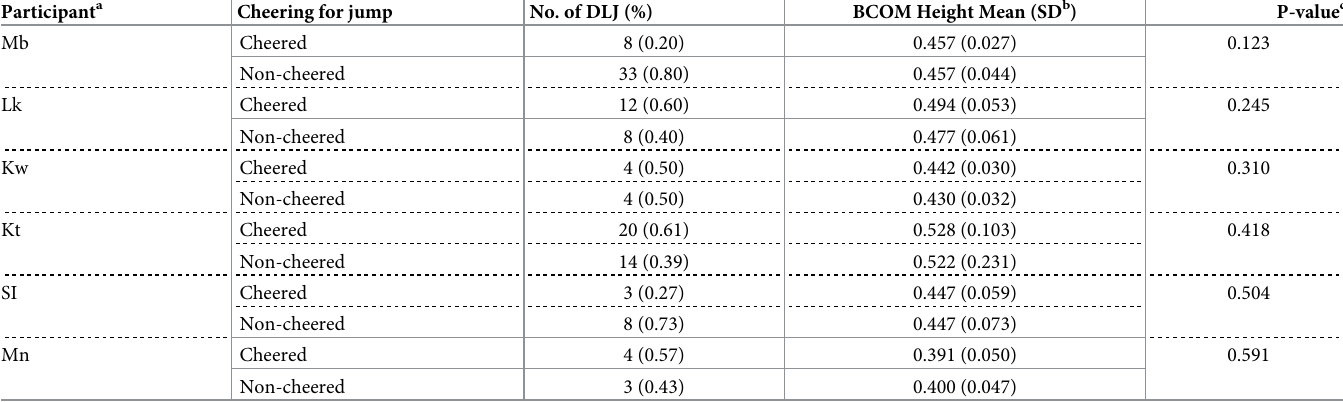
Table 5. Height difference of individual’s jumps in celebrative and non-celebrative